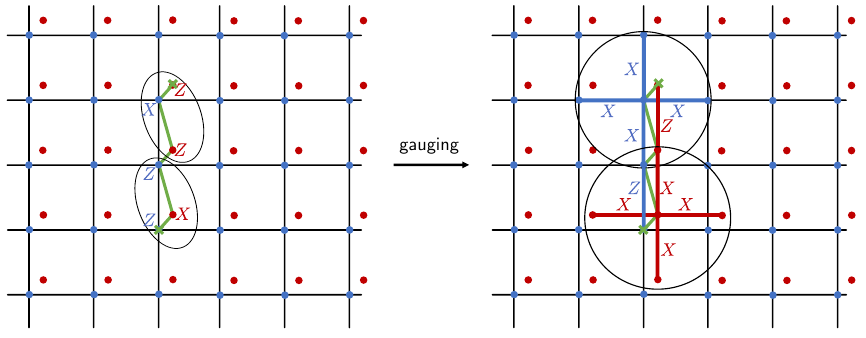
Figure 30: Left: On the background of the 2d paramagnetic Ising model, a 1d clus- ter state is decorated on an open string (green line) terminated at two point defects (green crosses). The single-body paramagnetic Ising term X ν is removed on the blue or red site coinciding with the green crosses. Right: After gauging the (cid:90) metry, the vertex X -stabilizer on the green line (between the endpoints) is dressed with an additional Z of a different color. The 4-body vertex X -stabilizers centered on the blue or red vertices coinciding with the green crosses are removed.